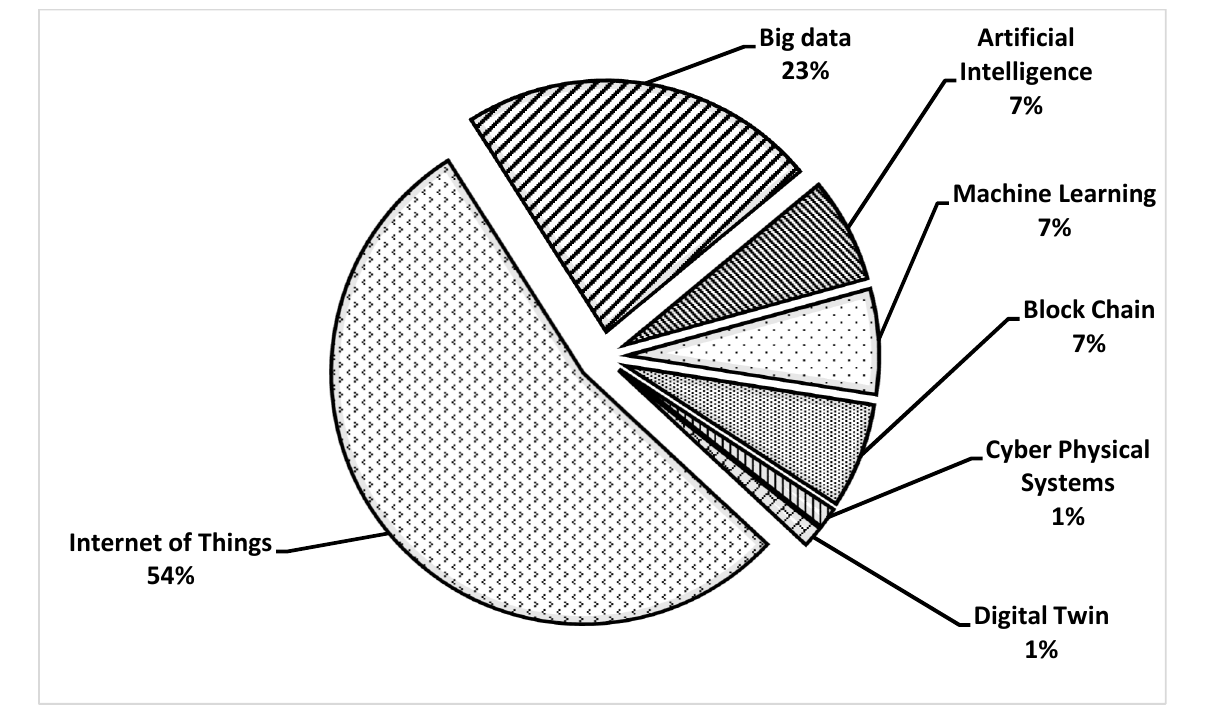
Figure 4. Percentage of Technological Tools. Table 3. Properties of FSC vs. Proposed Technologies. Reference